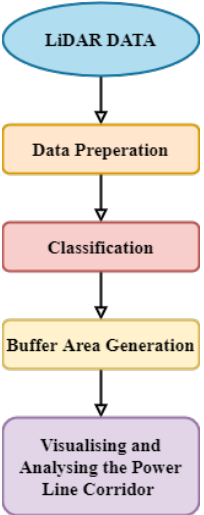
Figure 1. Workflow of the methodology.